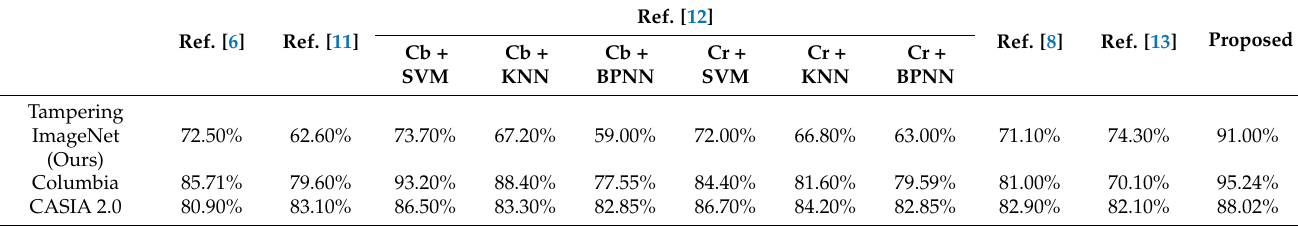
Table 3. The accuracy of the different image tampering detection